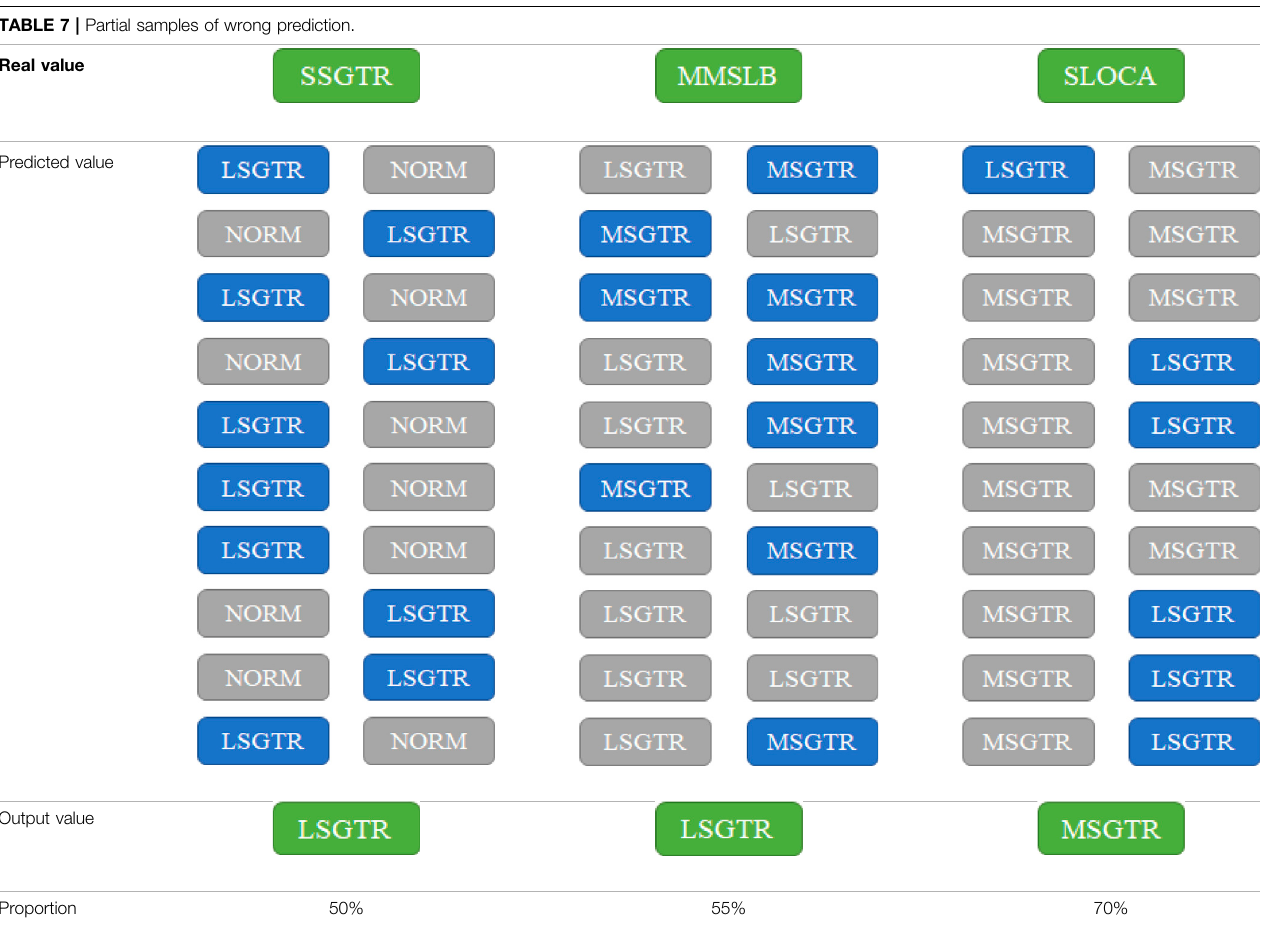
TABLE 7 | Partial samples of wrong